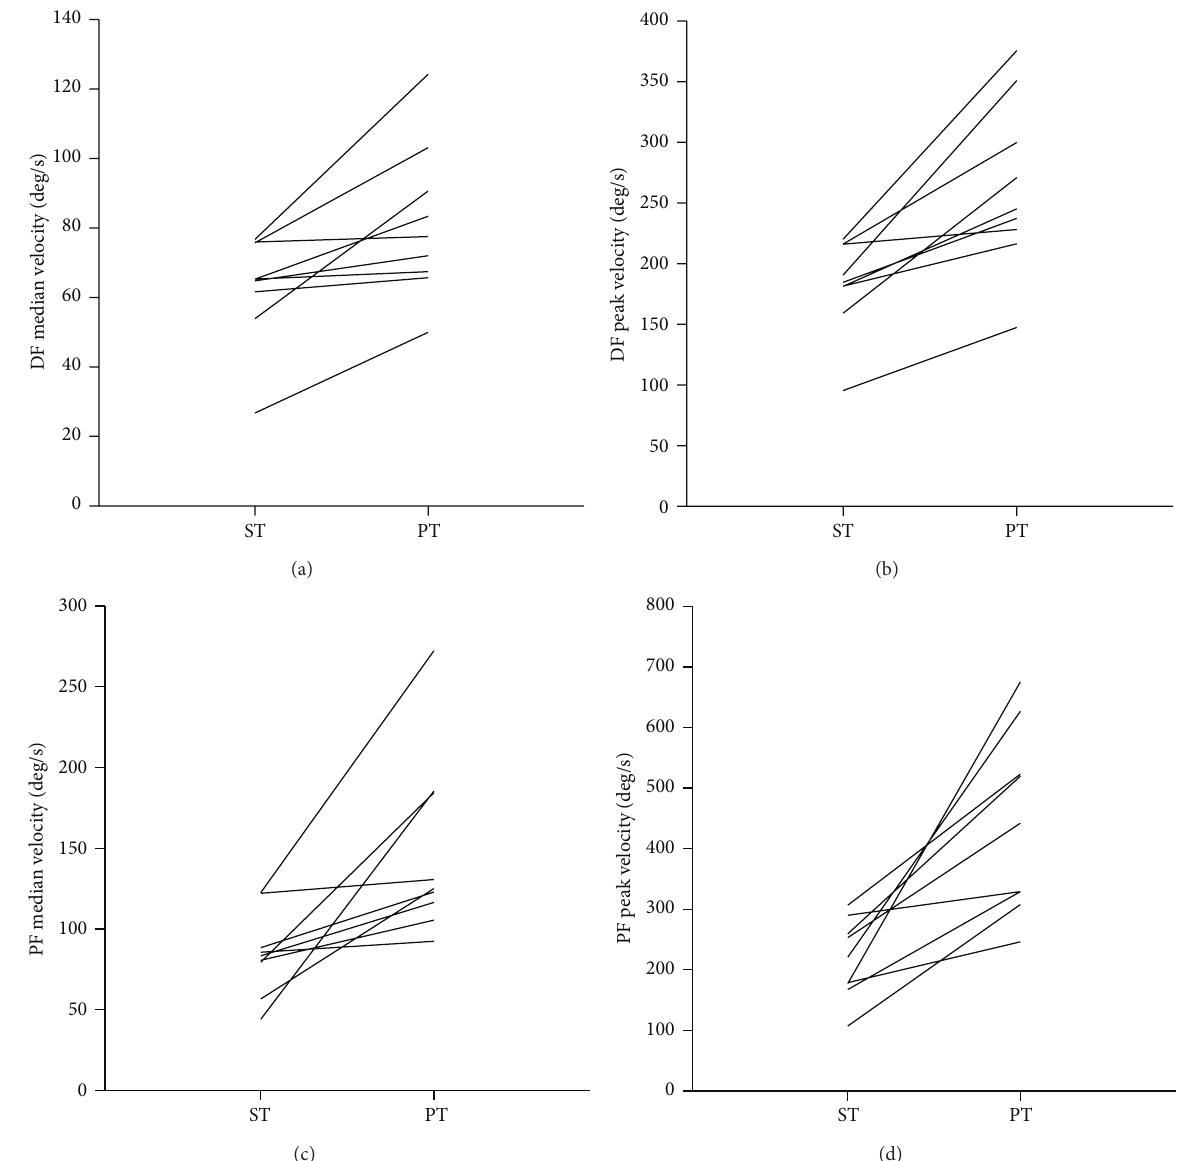
Figure 2: Individual data (i.e., each line is an individual) are shown for strength training (ST) and power training (PT) for (a) dorsiflexion (DF) median velocity; (b) DF peak velocity; (c) plantar flexion (PF) median velocity; and (d) PF peak velocity.